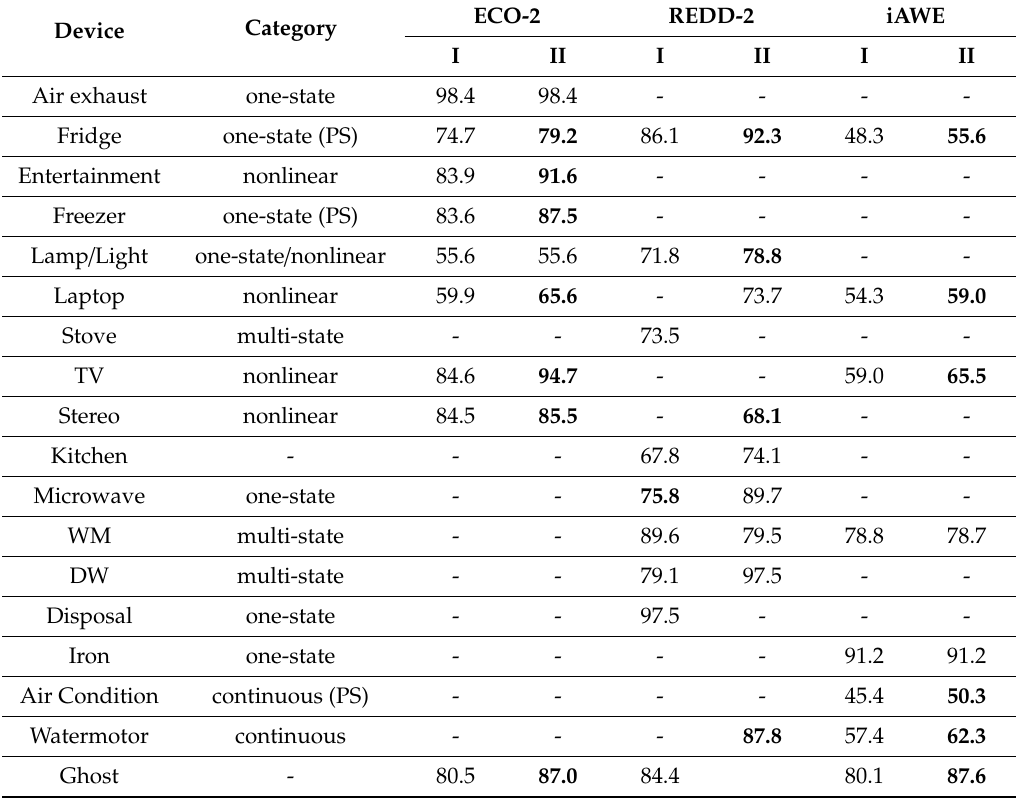
Table 4. Per device performance E m (%) of the one-stage (I) and the proposed two-stage fusion (II) ACC architecture using the best performance classifier (RF) conducted from the per dataset results. The superior method is given in bold while in the column “category” appliances with significant power spike are marked as